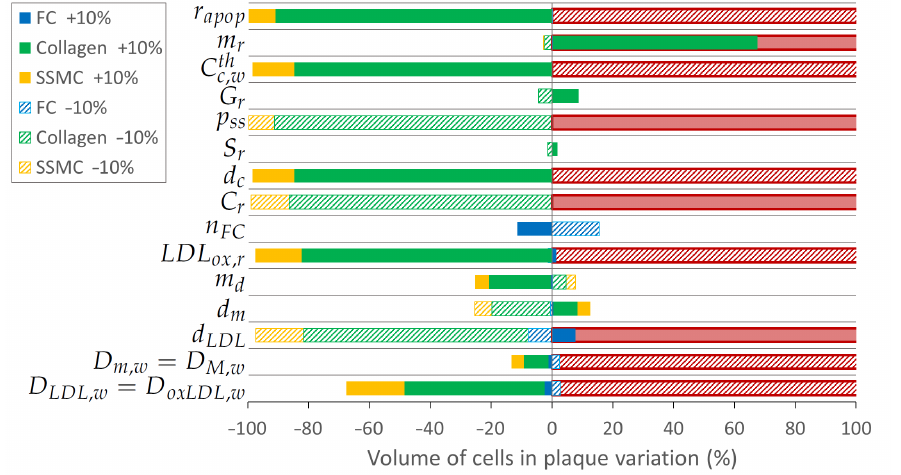
Figure 4. Variation of the volume of FC (blue color), SSMC (yellow color), and collagen (green color) when increasing and decreasing the parameters by 10% (solid and striped colors, respectively). Bars in red represent a variation of one of the substances higher than 100%.